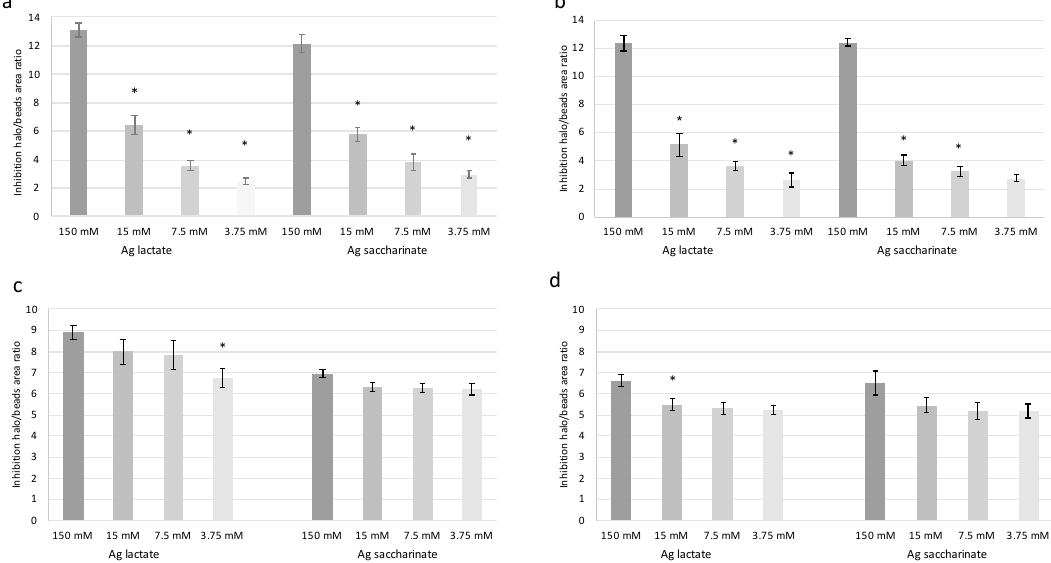
Figure 3. Antibacterial activity of silver evaluated by means of the agar diffusion method. Activity of silver lactate and silver saccharinate in alginate beads against ( a ) S. epidermidis and ( b ) P. aeruginosa . Activity of silver lactate and silver saccharinate in collagen beads against ( c ) S. epidermidis and ( d ) P. aeruginosa . In ( a , b ) * p < 0.05 compared to the corresponding higher concentration of silver salt (Bonferroni post hoc test). In ( c , d ) * p < 0.05 compared to the 150 mM concentrations of silver salt (Bonferroni post hoc test). Bars in the graphs indicate standard errors.